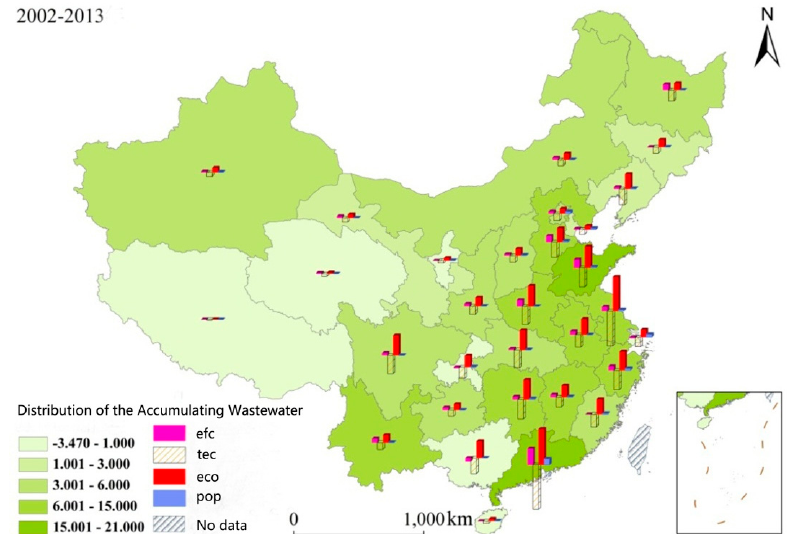
Figure 6. The distribution chat of the accumulated variation and index contribution of provincial wastewater discharge in China, 2012–2013.